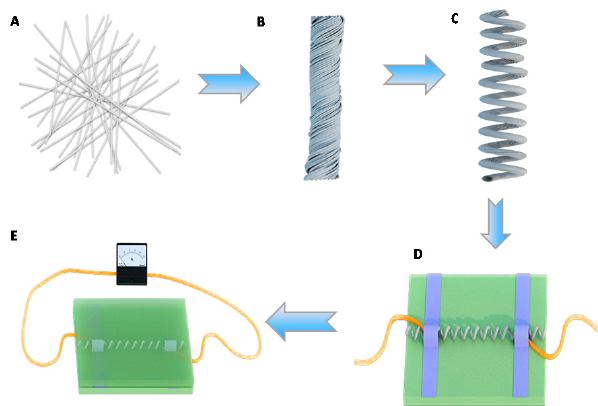
Figure1. SchematicillustrationoffabricatingAgnanowires / thermoplasticpolyurethanes(AgNWs / TPU) strain sensor with a spring-like configuration. A Electrospinning of the TPU nanofibrous membrane and dip coating AgNWs. B The TPU / AgNWs strain sensor with twisted configuration. C The TPU / AgNWs strain sensor with spring-like configuration. D The attachment of two electrodes. E Detecting of human